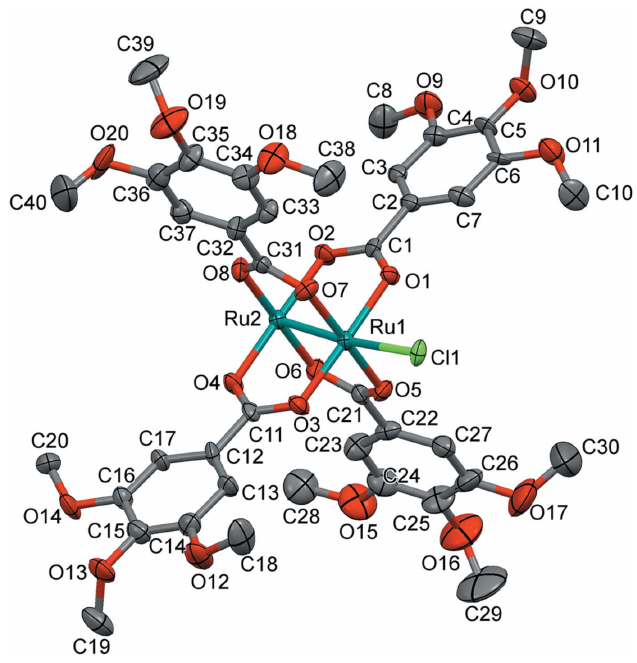
Figure 1 The structure of the dimeric unit of [Ru 2 Cl{ (cid:2) -O 2 CC 6 H 2 -3,4,5-(OMe) 3 } 4 ] n with displacement ellipsoids drawn at the 50% probability level. Hydrogen atoms have been omitted for clarity.